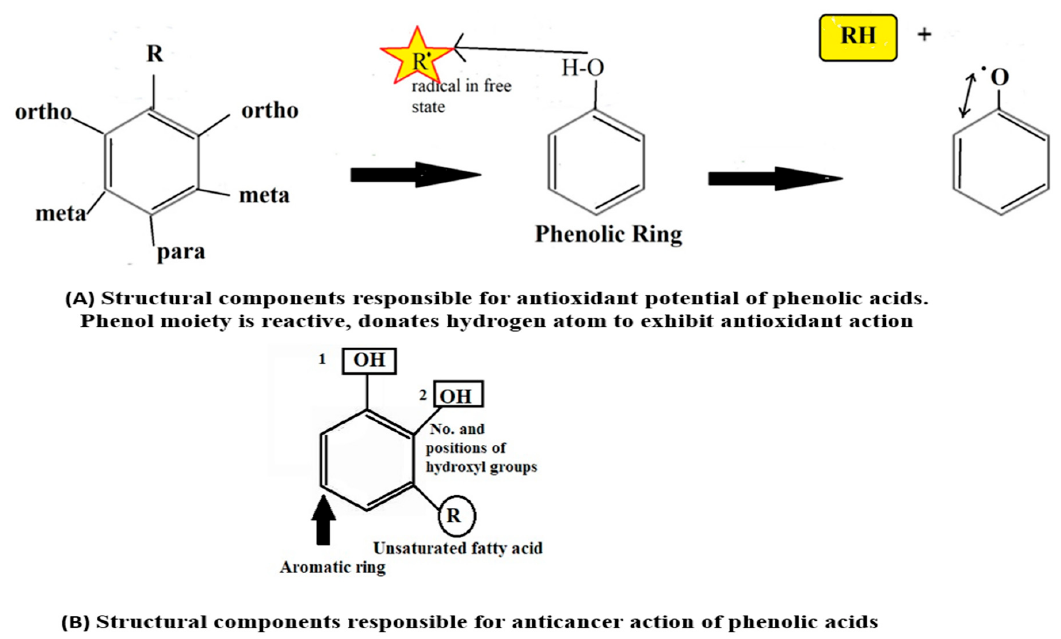
Figure 6. Structural activity relationship of phenolic acids. 1 and 2 showed hydroxyl groups